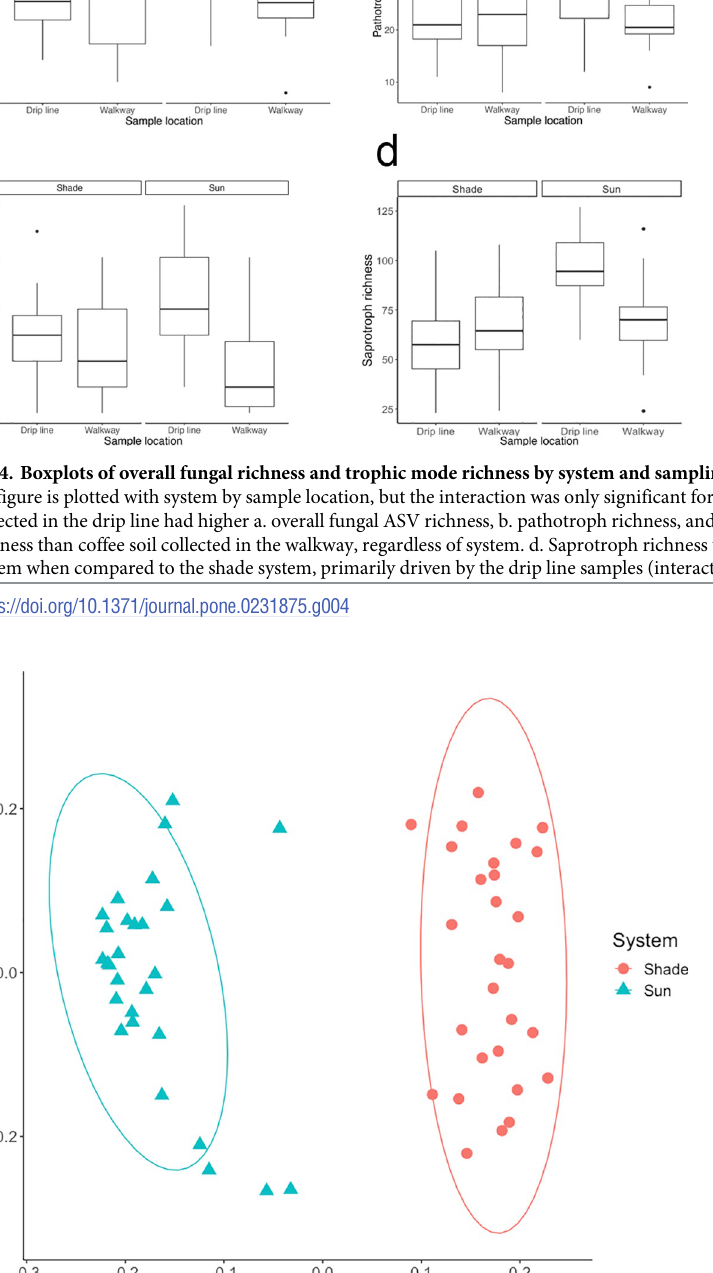
PLOS ONE | https://doi.org/10.1371/journal.pone.0231875 April 24,